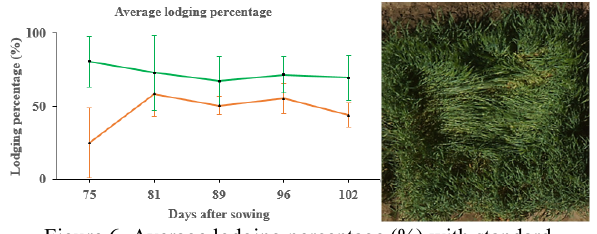
Figure 6. Average lodging percentage (%) with standard deviation for both sowing densities (high = green, low = orange) and genotype 1 (left). RGB image to illustrate the lodging pattern for genotype 1 (right).